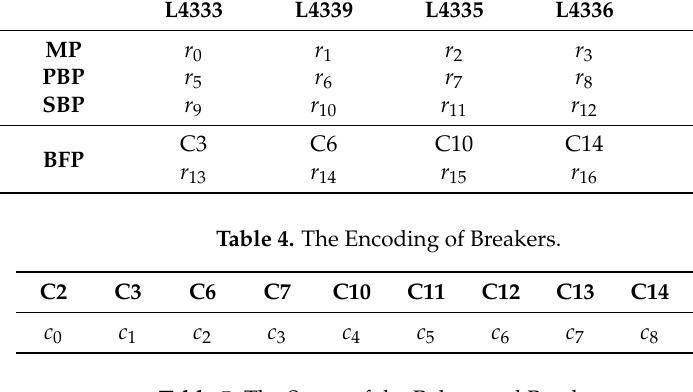
Table 5. The States of the Relays and